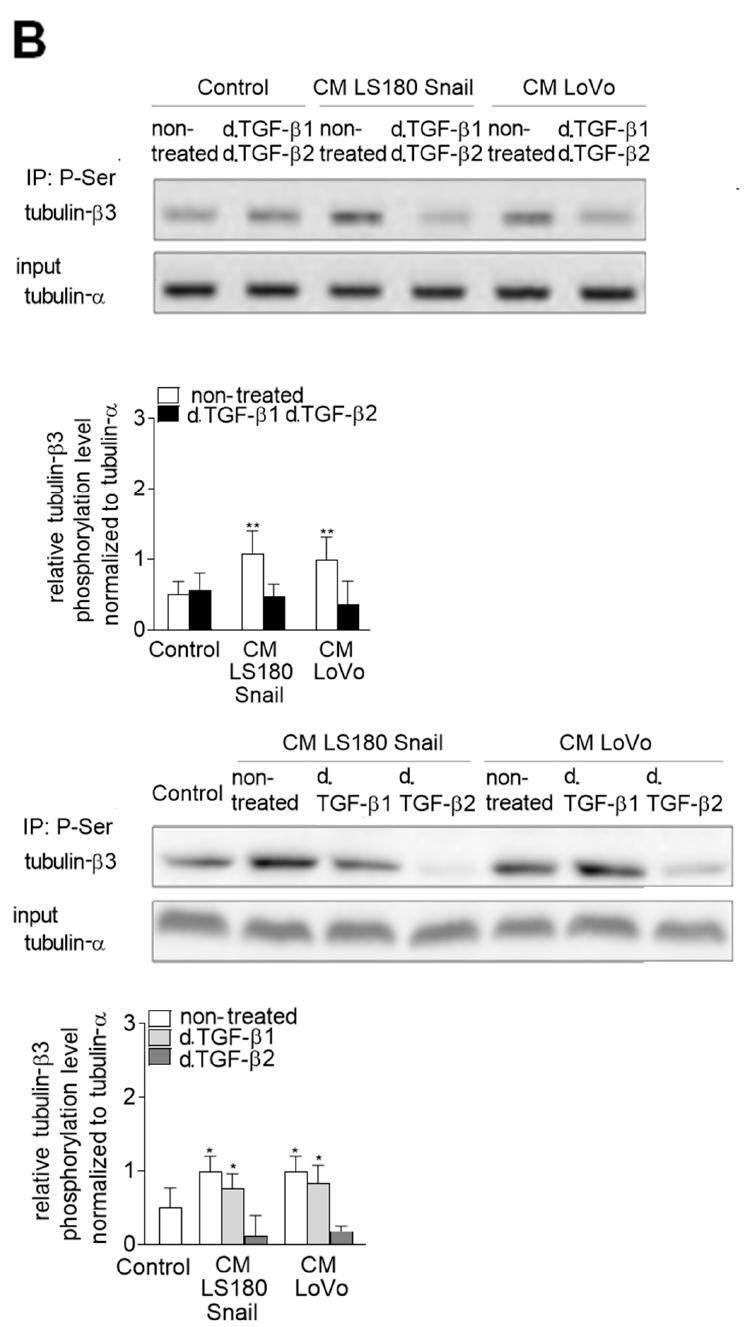
Figure 2. The expression of tubulin- β 3 and - β 4 are mainly regulated by cytokines belonging to the transforming growth factor- β (TGF- β ) family. ( A ) HMEC-1 cells were cultured in medium supplemented with conditioned medium (CM) isolated from invasive (LS180 Snail, LoVo) colon cancer cells where TGF- β 1 and/or TGF- β 2 were depleted (d. TGF- β 1 and/or d. TGF- β 2) for 216 h. Then levels of tubulin- β 3 and tubulin- β 4 were analyzed by Western blot assay. The protein levels are normalized to GAPDH. The results are provided as means ± SD ( n = 3); ** p < 0.01. The blots are representative of three independent experiments. ( B ) Simultaneously, the phosphorylation of tubulin- β 3 in microtubules fraction was determined by immunoprecipitation assay with rabbit antibodies recognizing phosphorylated protein followed by Western blot with mouse antibodies bound to tubulin- β 3. Additionally, the input was analyzed with mouse antibodies recognizing tubulin- α . The results are provided as means ± SD ( n = 3); * p < 0.05, ** p < 0.01.